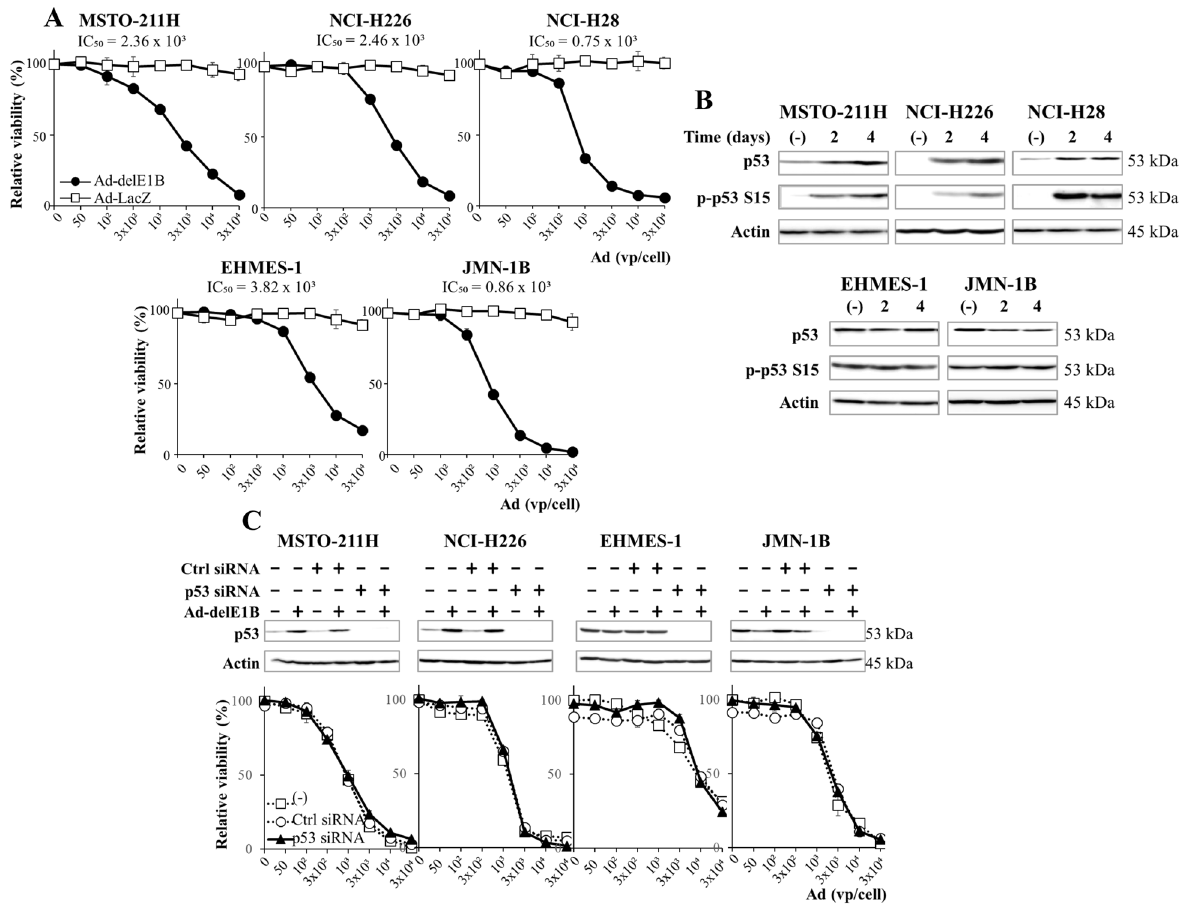
Fig. 1 Ad-delE1B-mediated growth inhibitory effects were independent of p53 expression. A Growth inhibitory effects of Ad-delE1B. Mesothelioma with the wild-type p53 (MSTO-211H, NCI-H226 and NCI-H28) or mutated p53 genotype (EHMES-1 and JMN-1B) were treated with Ad-delE1B or Ad-LacZ at various vp for 4 days. The cell viabilities were measured with the WST agent and relative viability was calculated based on untreated cells. IC 50 values (vp/cell) were calculated with GraphPad Prism software. Averages and SE bars are shown ( n = 3). B Cells were treated with Ad-delE1B (3 × 10 3 vp/cell) and cultured for 2 or 4 days. Expression of p53, phosphorylated p53 at Ser 15 (p-P53 S15), and actin as a control was examined with Western blot analysis. C Cells transfected with p53 siRNA or with non-target control siRNA (Ctrl siRNA) were treated with Ad-delE1B (3 × 10 3 vp/cell) for 4 days. Expression of p53 and actin as a control was examined with Western blot analysis. Cells transfected with siRNA were also treated with Ad-delE1B at various vp for 4 days and the cell viabilities were measured with the WST agent. Relative viability was calculated based on untreated cells. Averages and SE bars are shown ( n =